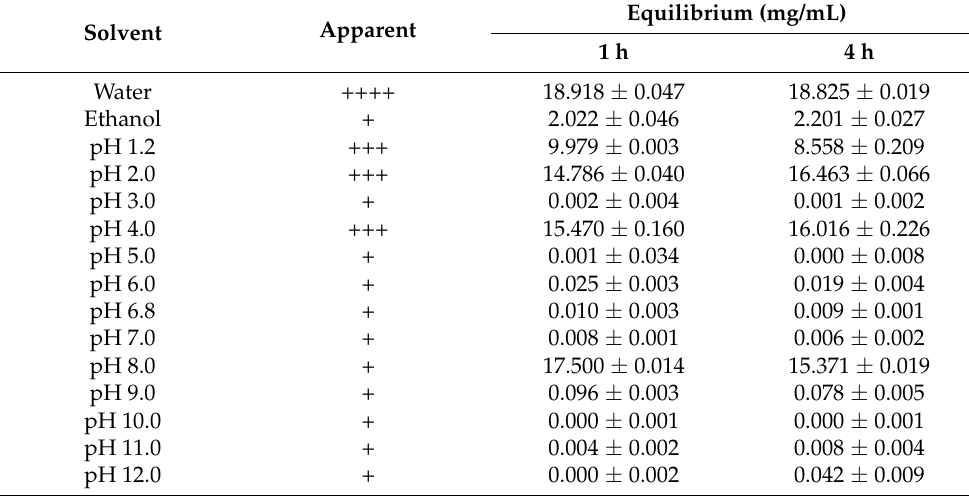
Table 2. The solubility of nafamostat mesylate in various solvents (n =